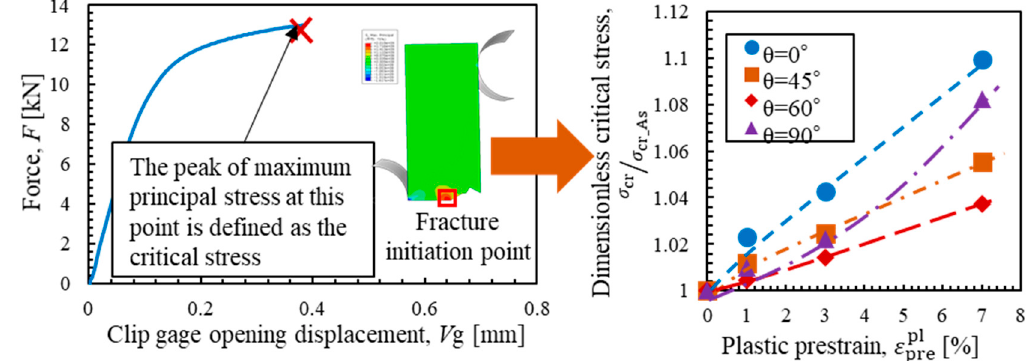
Figure 5. Change in the critical stress due to prestrain in different directions.